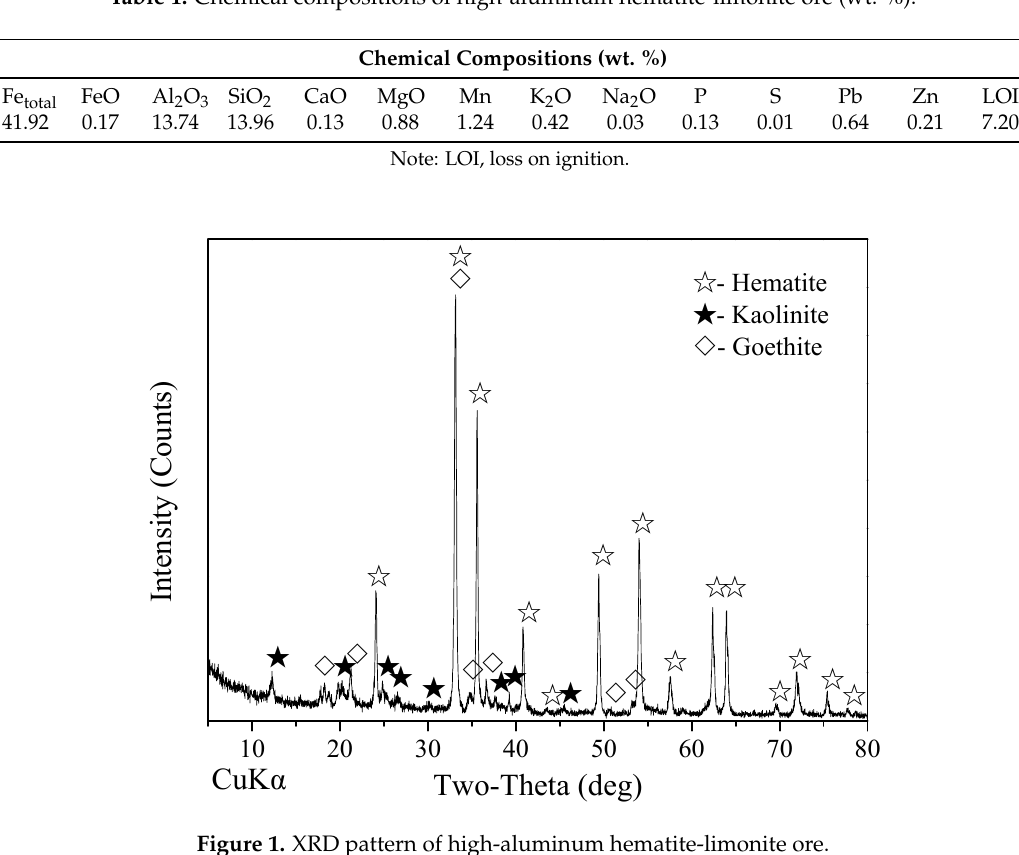
Figure 1. XRD pattern of high ‐ aluminum hematite ‐ limonite ore.